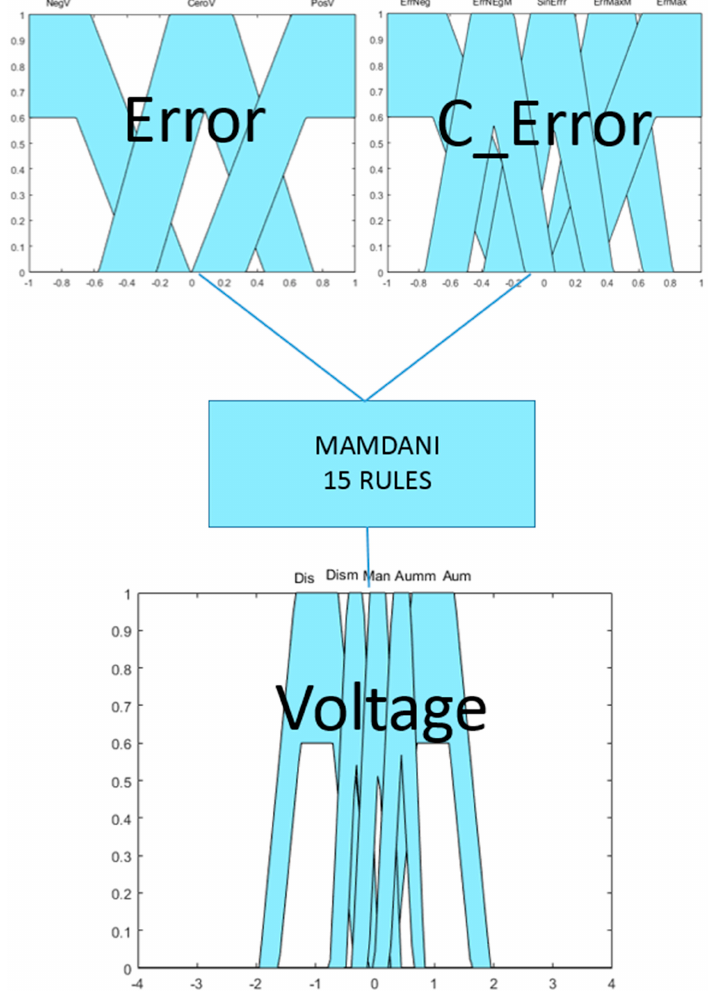
Figure 14. Best fuzzy structure for the fuzzy system with noise.